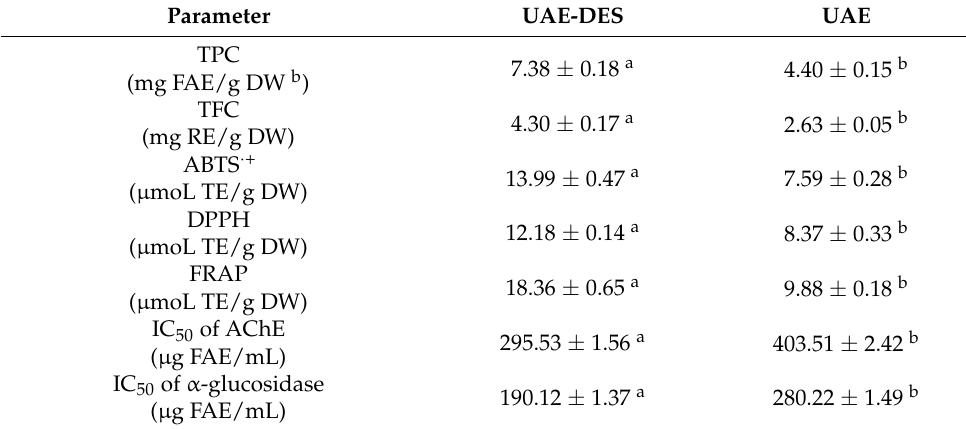
Table 4. TPC, TFC, antioxidant activity, α -glucosidase, and AChE inhibitory activities of phenolic extracts from foxtail millet husk obtained using UAE-DES and UAE a